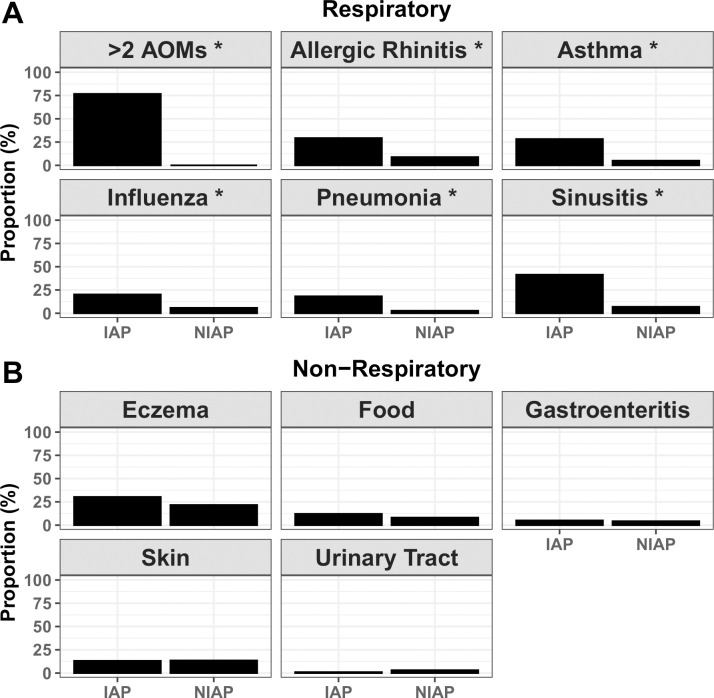
Comparison of individual conditions in IAP and NIAP children.Physician diagnosis of various respiratory (A) and non-respiratory (B) conditions were compared between IAP and NIAP children. *: p value <0.05 by chi square test comparing proportions.